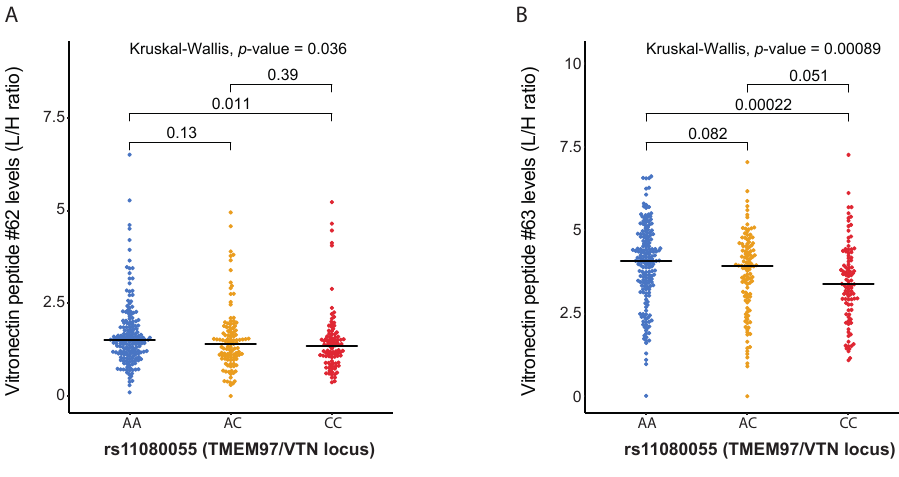
Figure 4. Vitronectin (VTN) levels show significant differences between genotype groups of AMD- associated variants at the TMEM97/VTN locus. Red indicates homozygous AMD-risk increasing genotype, while blue shows the homozygous AMD protective genotype, and yellow indicates the heterozygous genotype. The Kruskal–Wallis test was included to test if there was a difference between the three genotype groups, where possible. Medians of two genotype groups were compared with the Mann–Whitney-U test. Showing the distribution of peptide levels in light/heavy (L/H) in blood plasma for ( A ) VTN peptide #62 (DVWGIEGPIDAAFTR), stratified by rs11080055 genotype at the C2/CFB/SKIV2L locus; ( B ) VTN peptide #63 (FEDGVLDPDYPR), stratified by rs11080055 genotype at the C2/CFB/SKIV2L